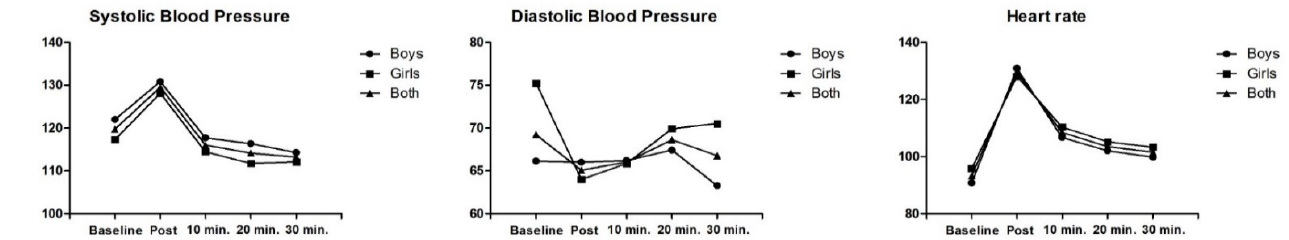
Figure 1. Cardiovascular parameters in adolescents with overweight/obesity after a Muay Thai training session.